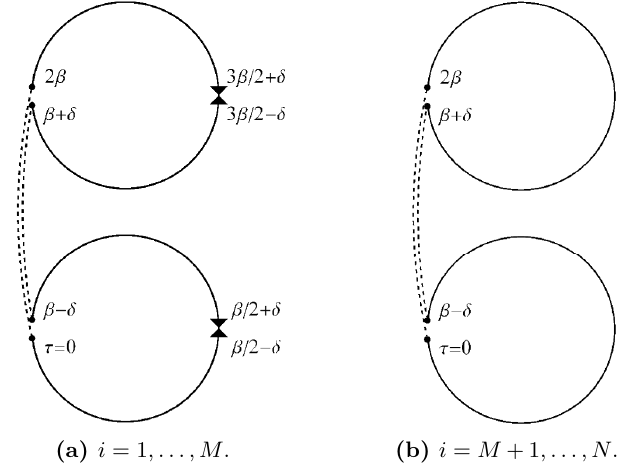
Figure 5. Imaginary time contour τ ∈ (0 , 2 β ) for the Euclidean path integral computing the numerator of equation (2.36). The points τ = 0 , β ± δ , β/ 2 ± δ , 3 β/ 2 ± δ and 2 β where boundary conditions must be imposed are labeled in the figure. The twist operator inserted in the left system is indicated by the dashed line. (a) The effect of the measurement operator on ψ i , i = 1 , . . . , M is indicated by the triangles, corresponding to the second and third lines of the boundary conditions (2.39). At the insertion point of the twist operator, the boundary conditions are given by the first line of (2.39). (b) There is no measurement operator for ψ i , i = M + 1 , . . . , N . The boundary conditions are then simply set by the first line of